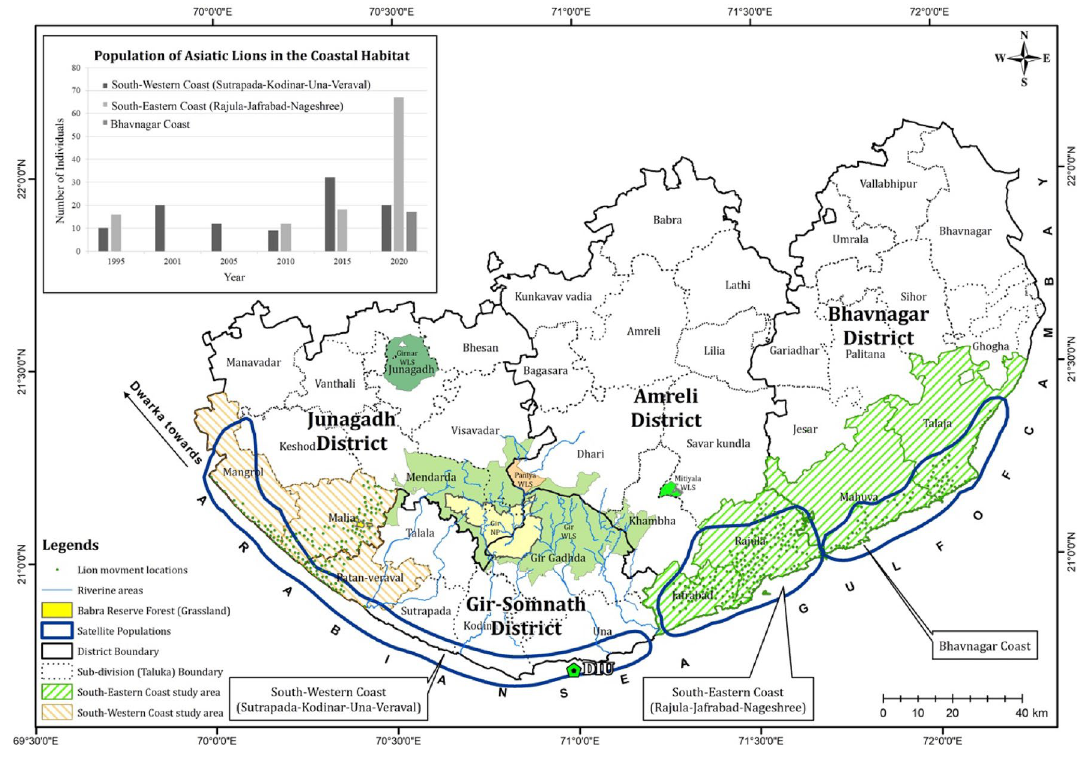
Figure 1. Location of the eastern and western coastal habitats in the Asiatic Lion Landscape in Gujarat. The inset shows the population of lions in the coastal habitats.